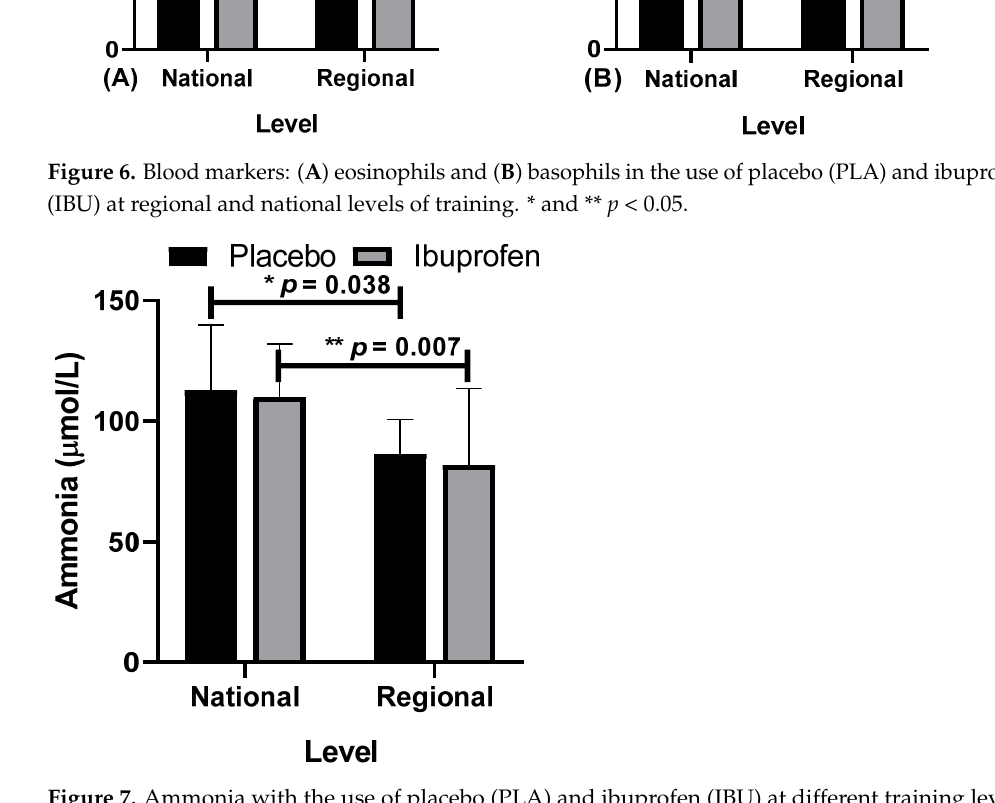
Figure 6. Blood markers: ( A ) eosinophils and ( B ) basophils in the use of placebo (PLA) and ibu- profen (IBU) at regional and national levels of training. * and ** p < 0.05.